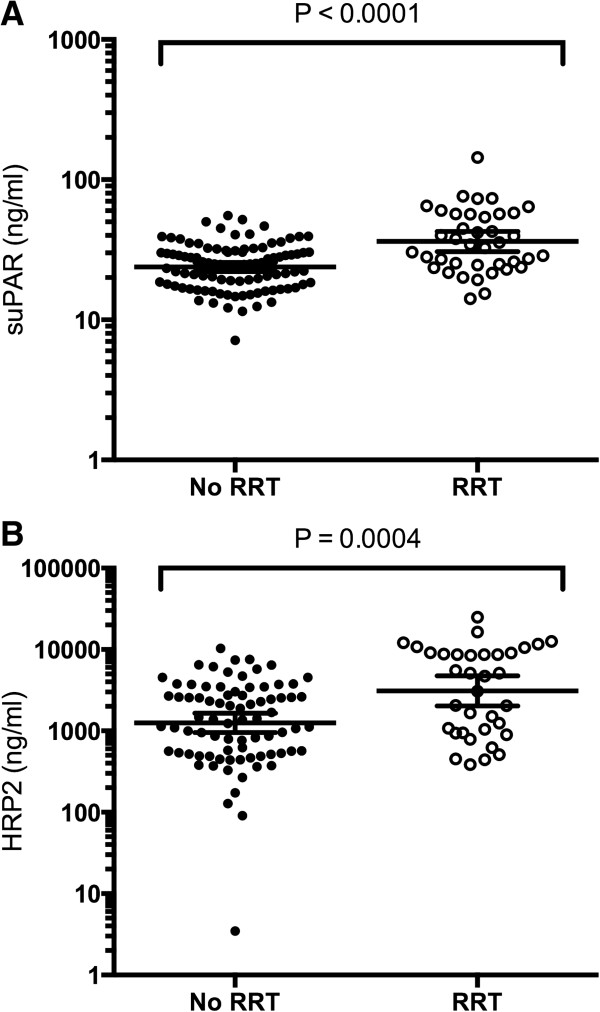
Scatterplots of cohort stratified by renal replacement therapy requirement. (A) Plasma suPAR, and (B) plasma HRP2. Biomarkers were log transformed (log10) for normality. T-tests were performed for comparisons between groups. RRT = renal replacement therapy; suPAR = soluble urokinase–type plasminogen activator receptor; HRP2 = P. falciparum histidine rich protein 2.